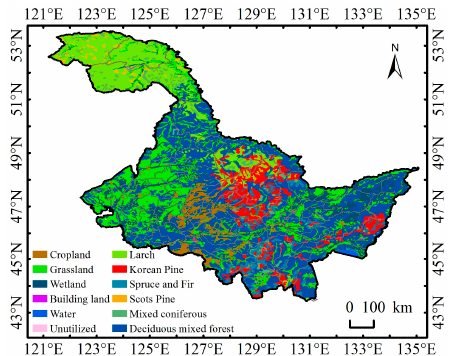
Figure 3. Map to show the spatial distribution of land use in Heilongjiang Province during the 1900s.